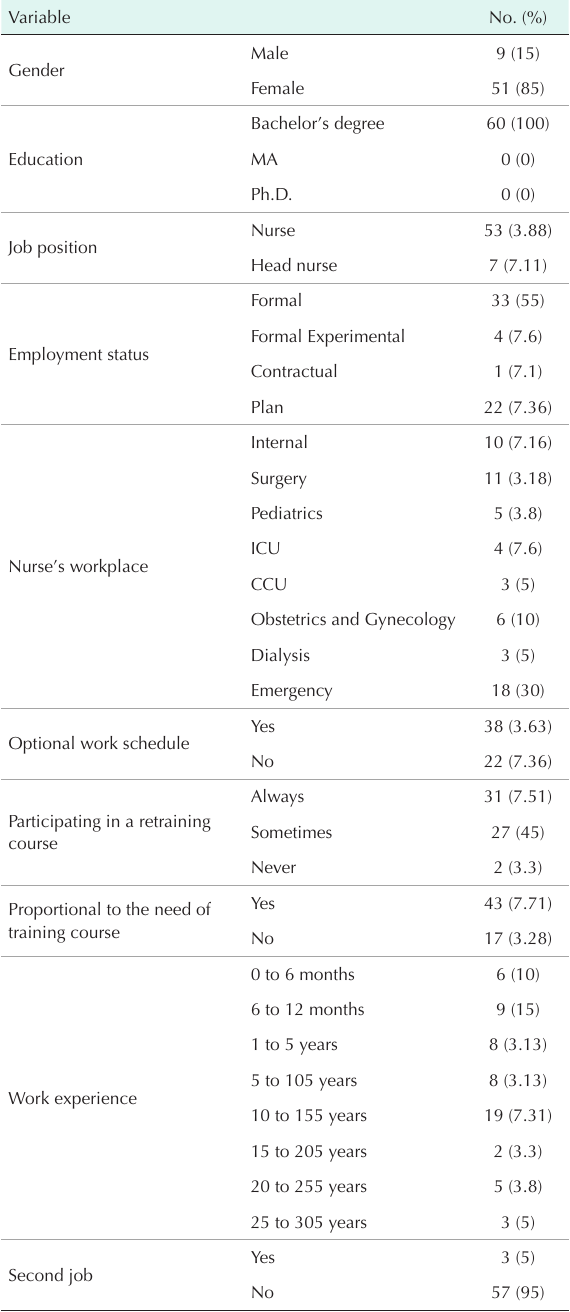
Table 2. Demographic Characteristics of Nurses Participating in the Study